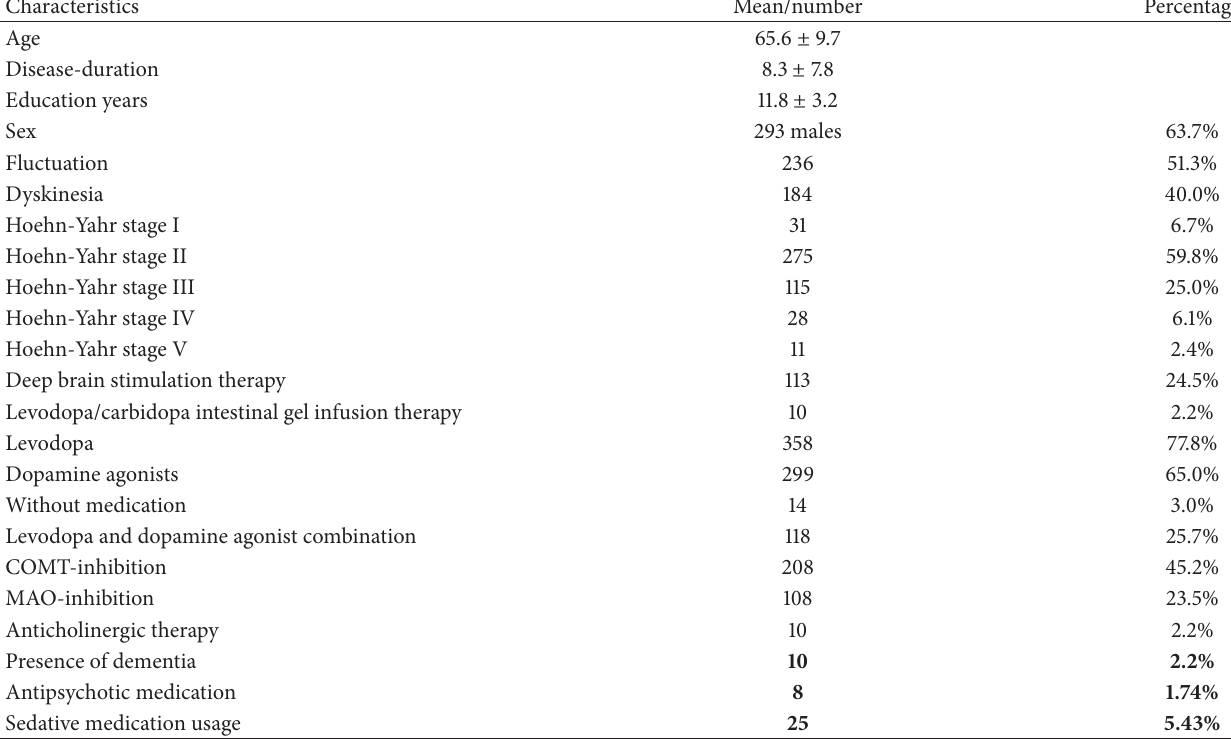
Table 1: Clinical characteristics of the study